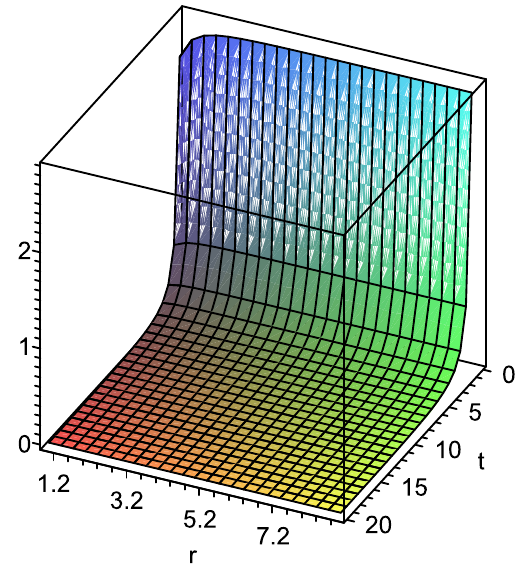
Fig. 1 The behavior of ρ + p r with respect to r and t . The model parameters are chosen as w = − 1 / 3, R 1 = 2 and r 0 = 1 in 4 dimen- sions